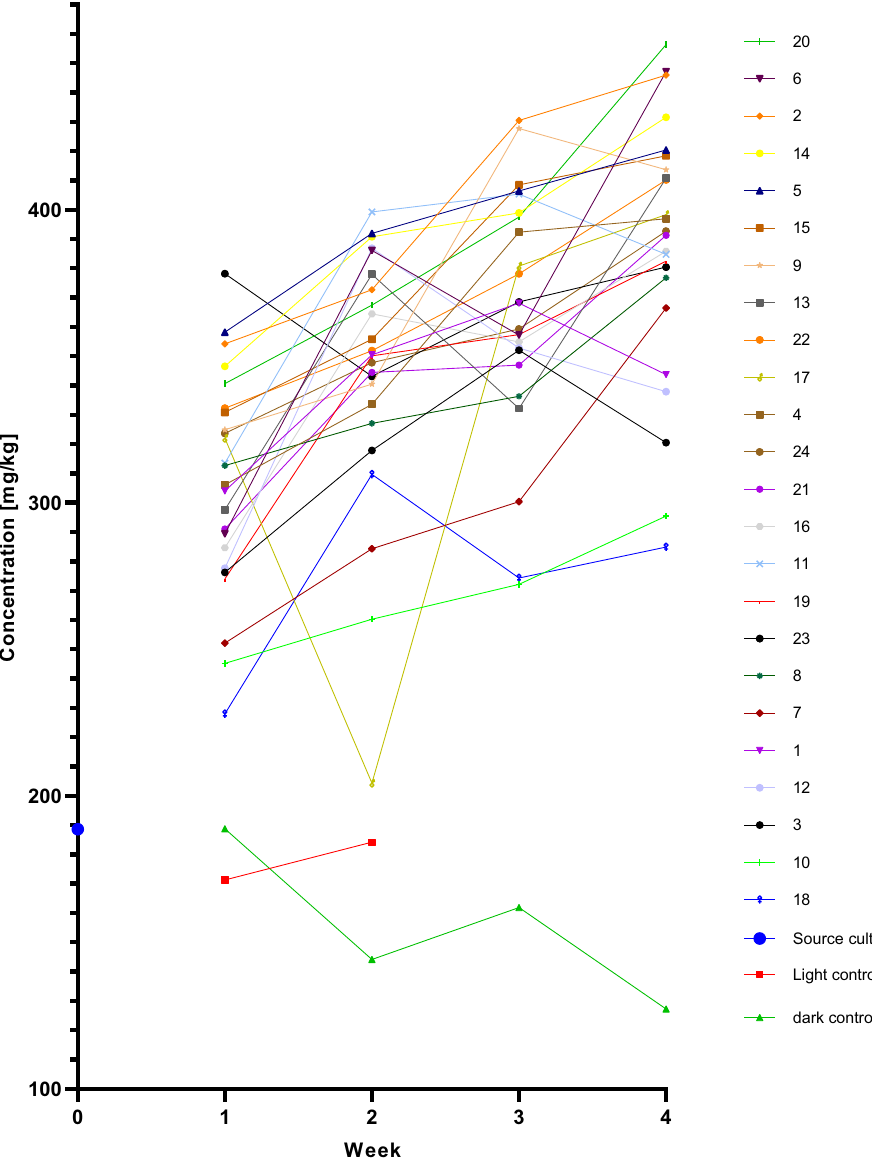
Figure 3. Total anthocyanin content of grapevine cultures under different lighting conditions and at different time points. All cultures originated from the same source culture. All 26 replicate cultures were cultivated for 4 weeks at 26 °C, shaking at 140 rpm. Every week, 15% of the cells (v/v) were subcultured and the remaining cells were collected for LC-IMS-HRMS analysis to determine anthocyanin concentrations. Each line represents a lighting condition: conditions 1–24 are based on the DoE model (Table 1) with an intensity of red + green + blue light = 50 µmol m 2 s 1 and UV light either off or on for 1 h (12–1 pm) each day (9 µmol m 2 s 1 ). Those cultures were cultivated in the LiS under 24 different lighting conditions with a 16-h photoperiod. The light control was cultivated according to the conditions of the routine/source culture (standard shaking incubator, light positioned in the ceiling, 16-h photoperiod, 80 µmol m 2 s 1 ), but was contaminated after 3 weeks, therefore the data represent only 2 weeks of cultivation. The dark control was cultivated in the absence of light. There seemed to be an error with sample preparation or analysis of culture 17 in week 2, but we decided to keep the point in the graph in order to not delete any